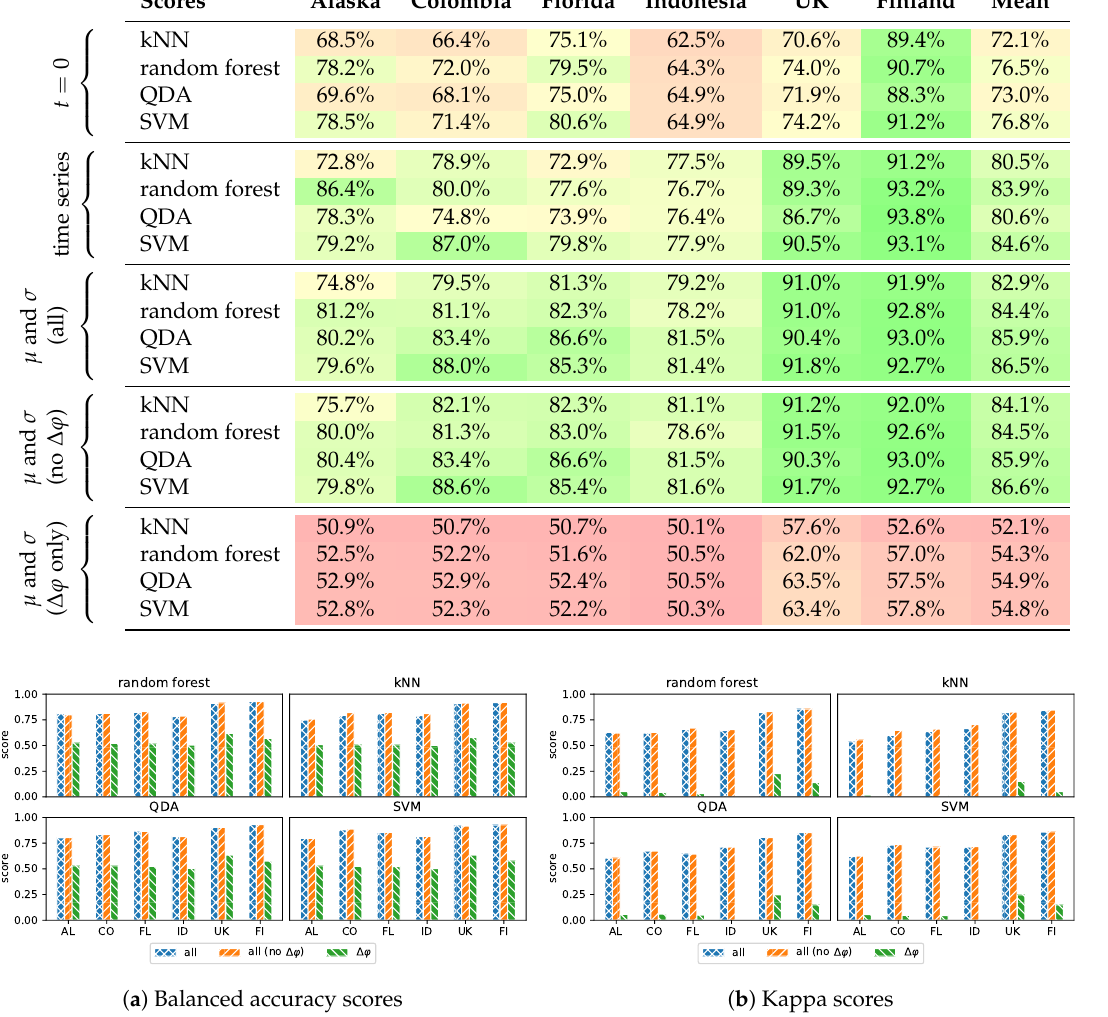
Figure 8. This figure visualizes the performance of the four classifiers tested (random forest, kNN, QDA, and SVM) for each study site, as measured by the balanced accuracy score ( a ) and Cohen’s Kappa ( b ). Three different subsets of variables are represented; VV, VH, and the phase difference ∆ ϕ (blue), only VV and VH (orange), and only ∆ ϕ